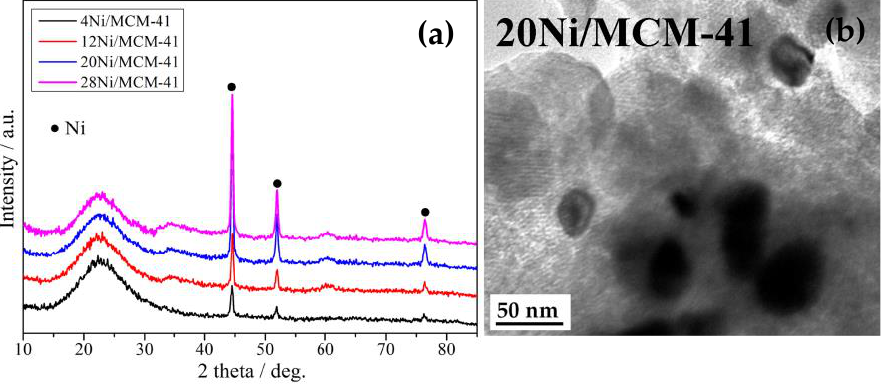
Figure 9. XRD patterns ( a ) and TEM image ( b ) of spent x Ni/MCM-41 catalysts after 45 h reaction. Table 3. Textural properties and Ni crystallite size of fresh and spent x Ni/MCM-41 catalysts. Specific Catalyst